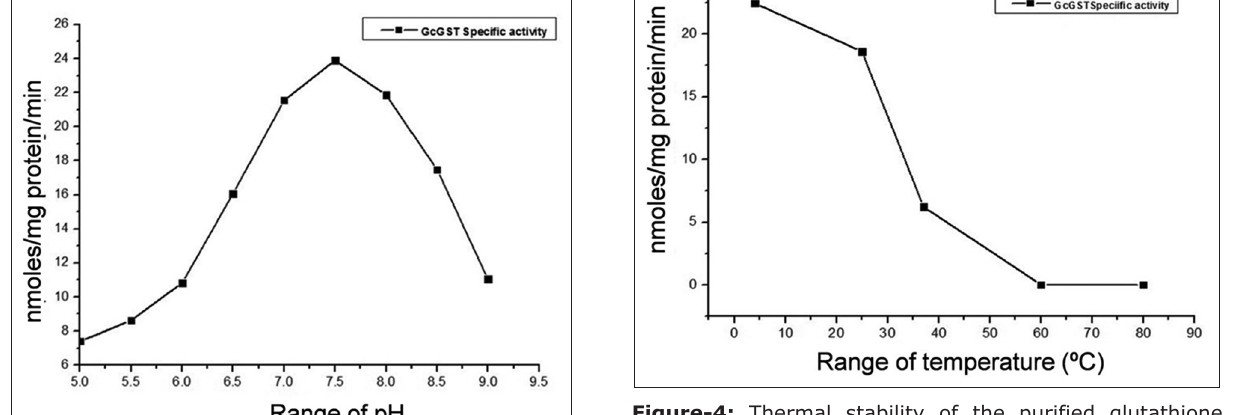
Figure-4: Thermal stability of the purified glutathione S-transferase (GST) proteins from Gastrothylax crumenifer in 100 mM sodium phosphate buffer (pH 7.4) pre- maintained at five different temperatures (4, 25, 37, 60, and 80°C). Purified GSTs (1 mg) were incubated in 1 ml of phosphate buffer solution having different temperatures for 30